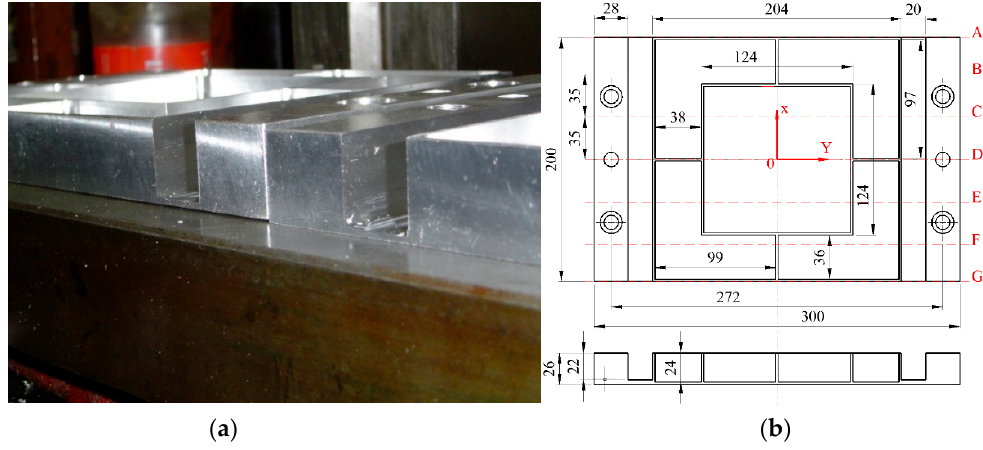
Figure 8. The ( a ) comparison of the maximum deformation of the Specimen 1 and ( b ) size and structure of the specimen.